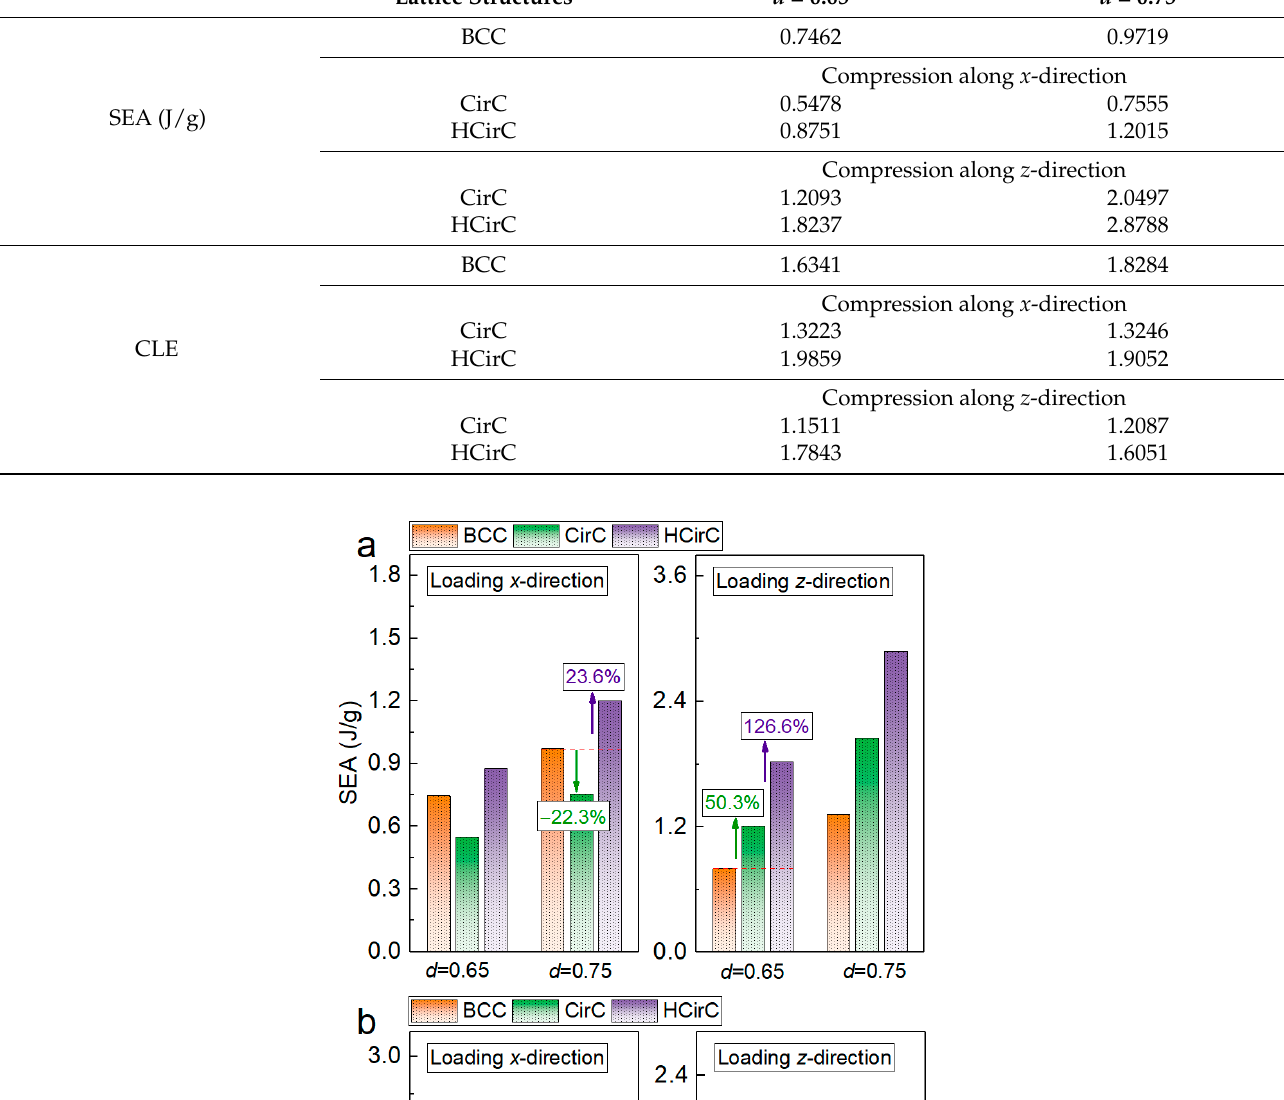
Table 5. Comparison of the energy absorption properties of lattice structures BCC, CirC, and HCirC. Lattice Structures